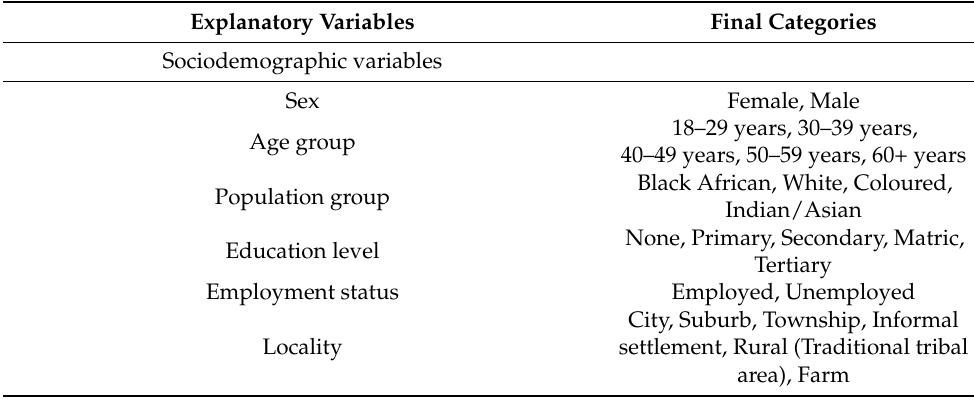
Table 1. Explanatory